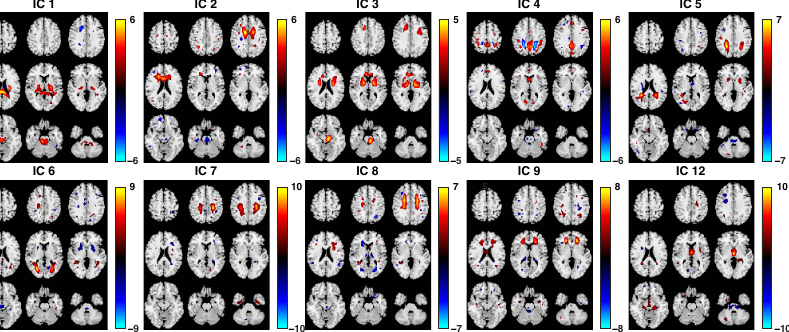
Figure 4. Spatial maps of 10 retained ICs from the FA dataset. These results reflect the IC results of SZ and HC groups combined. The brain maps are visualized at color and negative Z values in